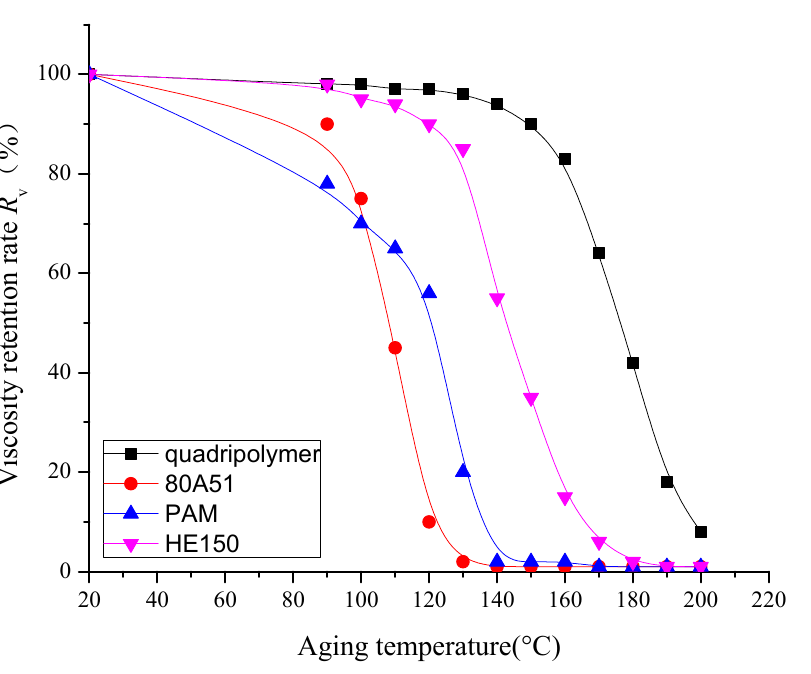
Figure 6. Viscosity retention rate of polymers at different aging temperature.